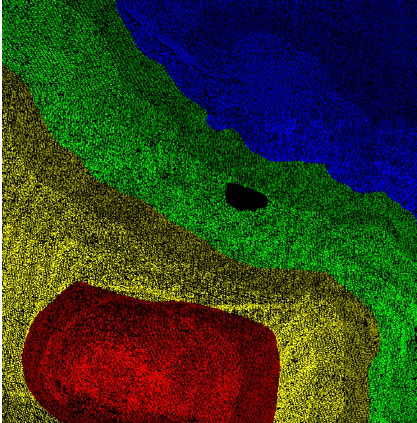
Figure 6. Original point cloud in urban areas